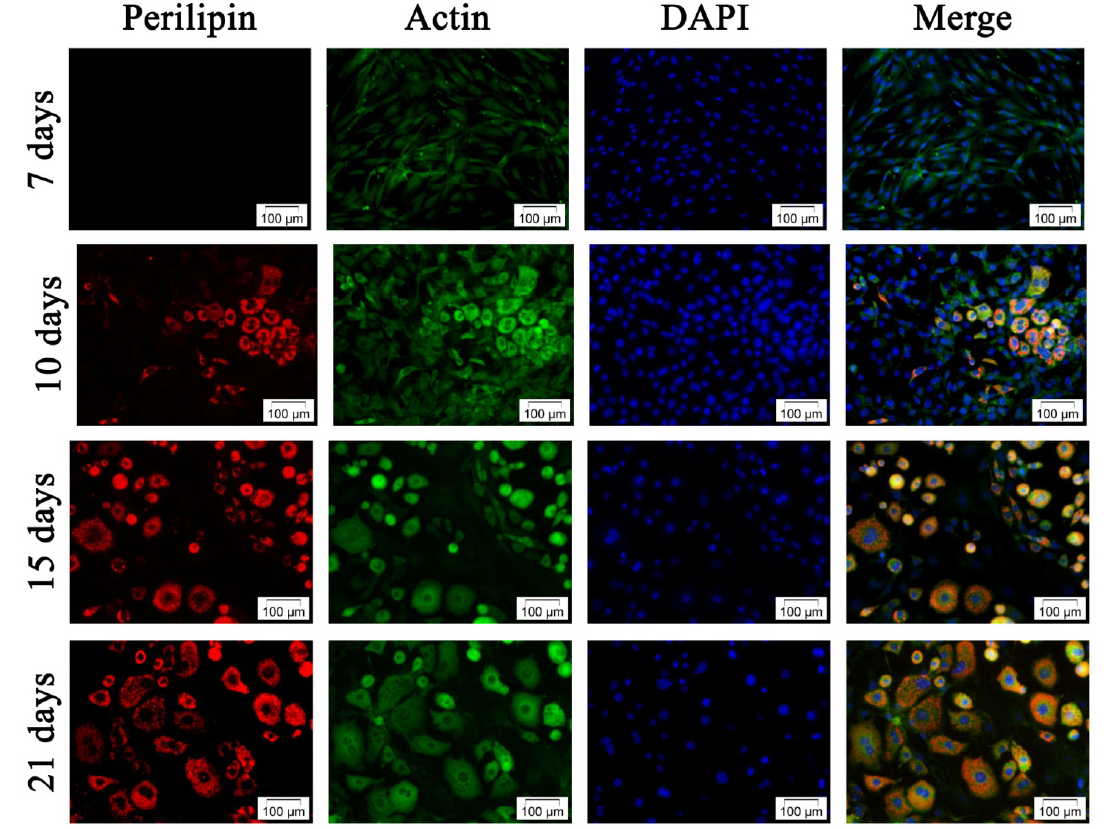
Figure 4. Fluorescence micrographs of the third passage hADSCs during adipogenic differentiation, stained with TRITC conjugated antiperilipin antibody (red), FITC conjugated phalloidin for actin filament labeling (green) and DAPI for highlighting the nuclei